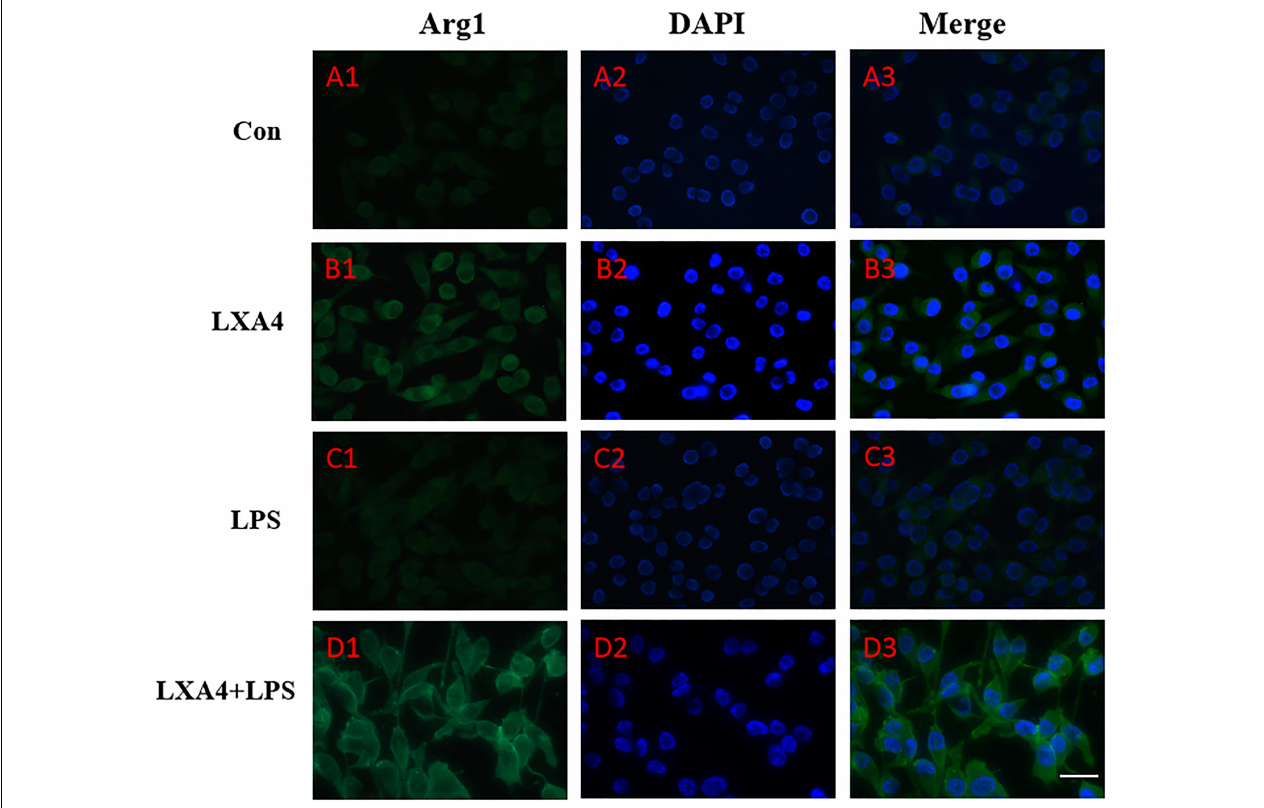
FIGURE 6 | Immunofluorescence images showing the BV2 microglia after LPS stimulates which were not labeled with Arg1 antibody, with LXA4, the expression of Arg1 is expressed at high levels. Green fluorescence indicated Arg1 positive cells, while blue fluorescence indicated DAPI-labeled nuclei. Scale bar: 20 µ